Question: What kind of plot is shown here?
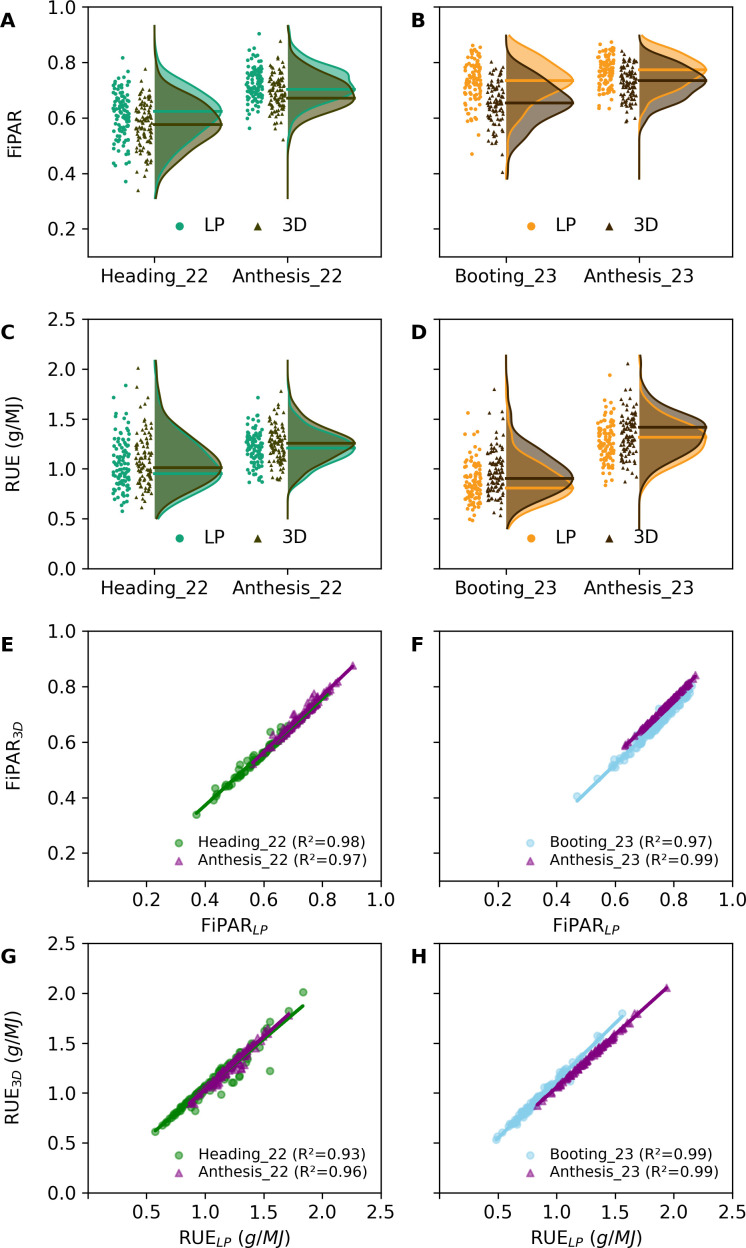
Answer: line